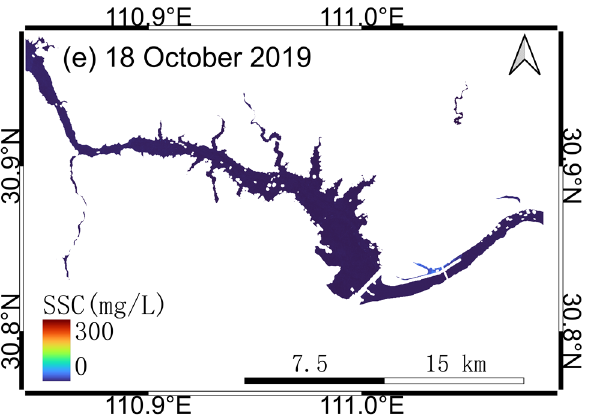
Figure 11. Spatiotemporal distributions of the retrieved SSC above and below the Three Gorges Dam. Panels ( a – e ) demonstrate the process of muddy water storage and clear water release. ( a ) 1 April 2019, ( b ) 25 July 2019, ( c ) 14 August 2019, ( d ) 23 September 2019, and ( e ) 18 October 2019.